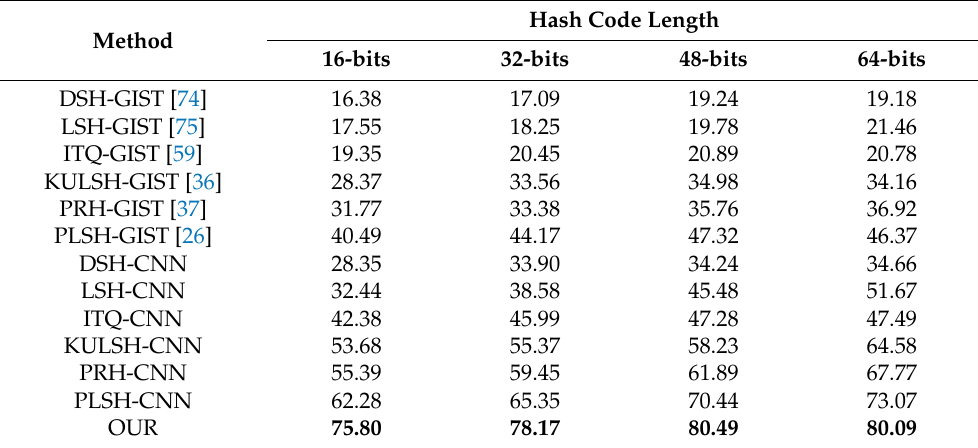
Table 2. The mean average precision ( MAP ) retrieval results on the UCMD dataset; we give separate hash retrieval results for 16, 32, 48, 64 bits. The testing set has 420 images (each category randomly takes 20% of the images).